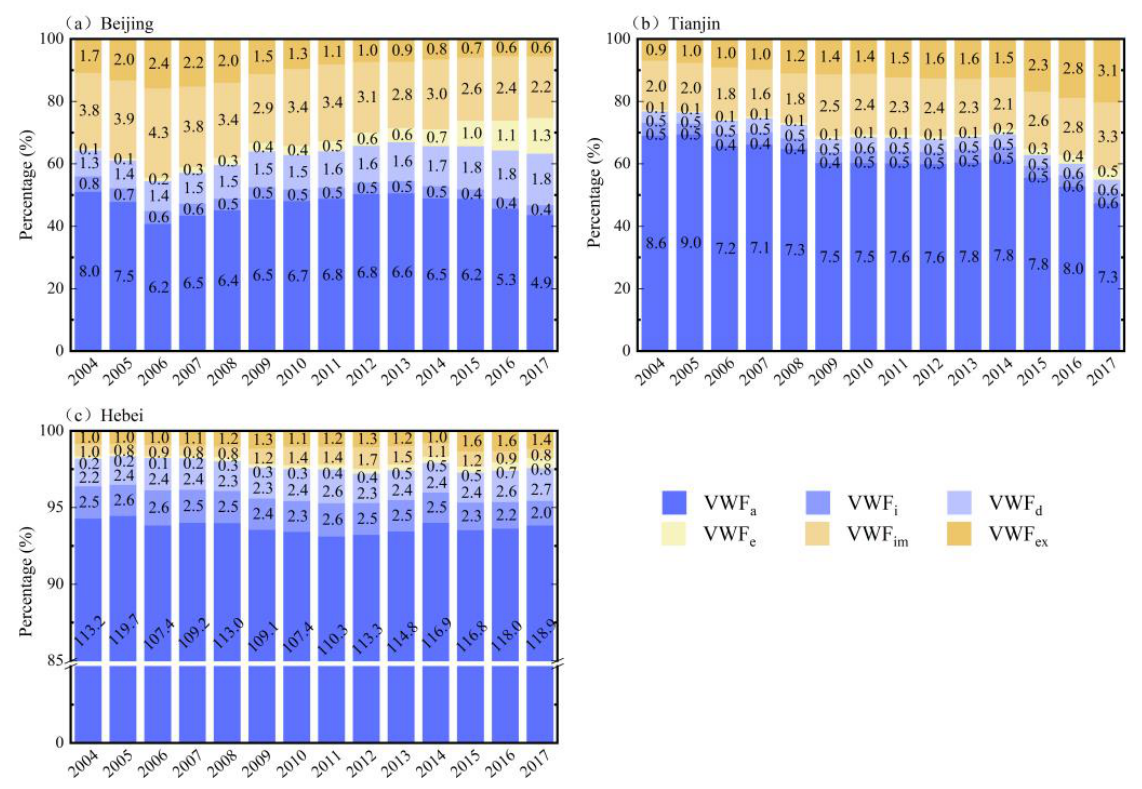
Figure 5. The proportion of VWF (with each component’s amount numbered in black font) in the BTH region.